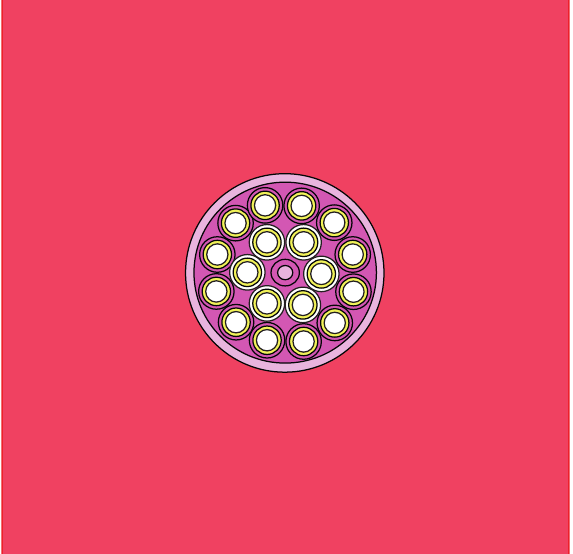
Figure 1: The model of RBMK-1500 fuel